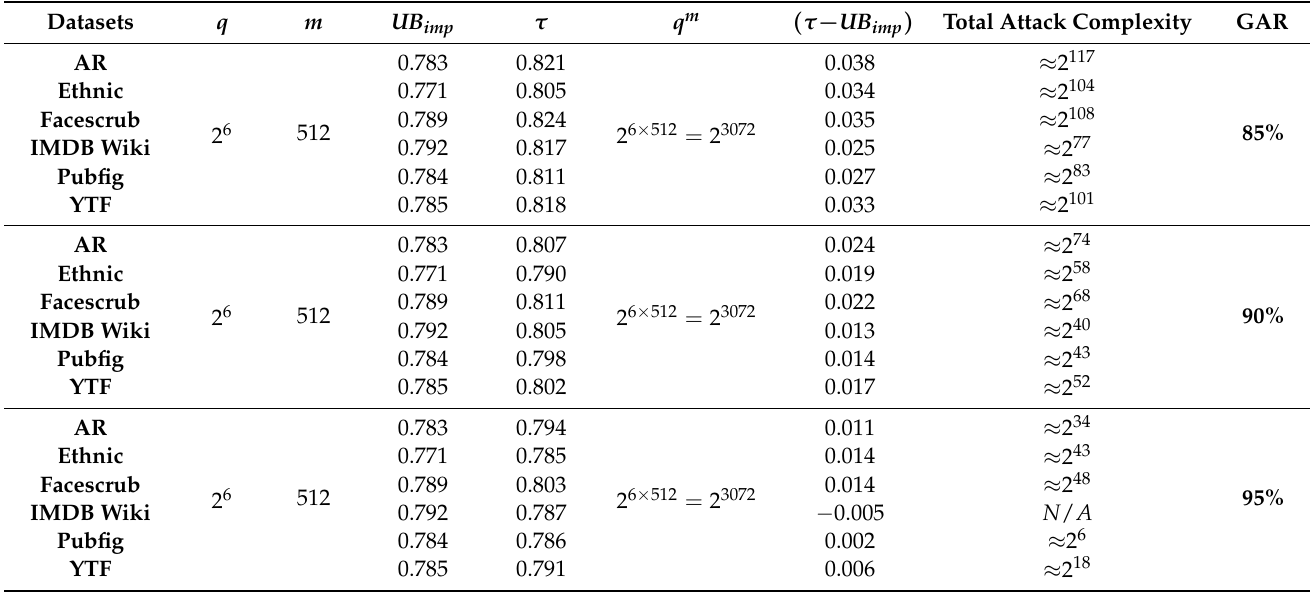
Table 8. Complexity of the false acceptance attack on the proposed